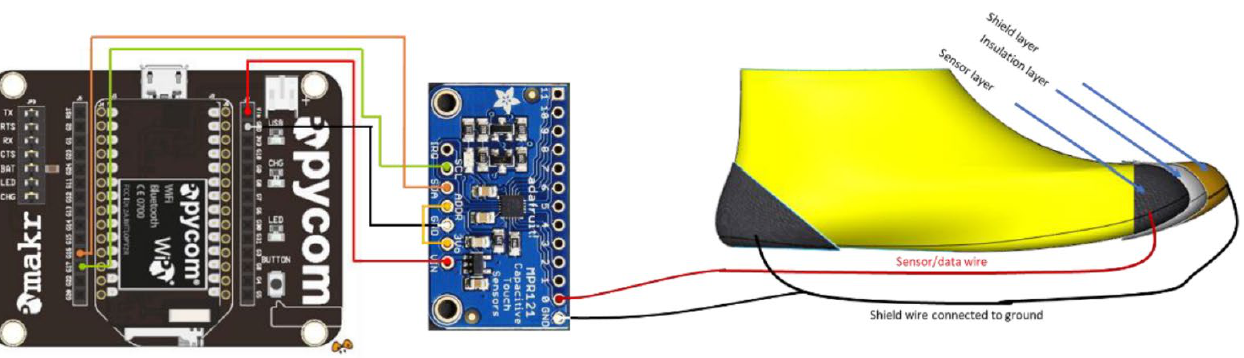
Figure 18. Physical connection from the electronics unit to the shoe sensor unit. The grounded heel sensor and non-grounded heel sensor connected to Pycom and MPR121 are shown in Figure 19.